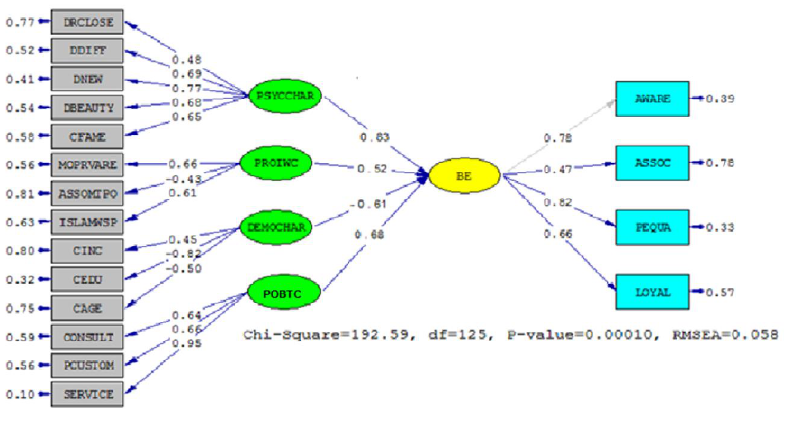
Fig. 1. The structural equation model of research for standard